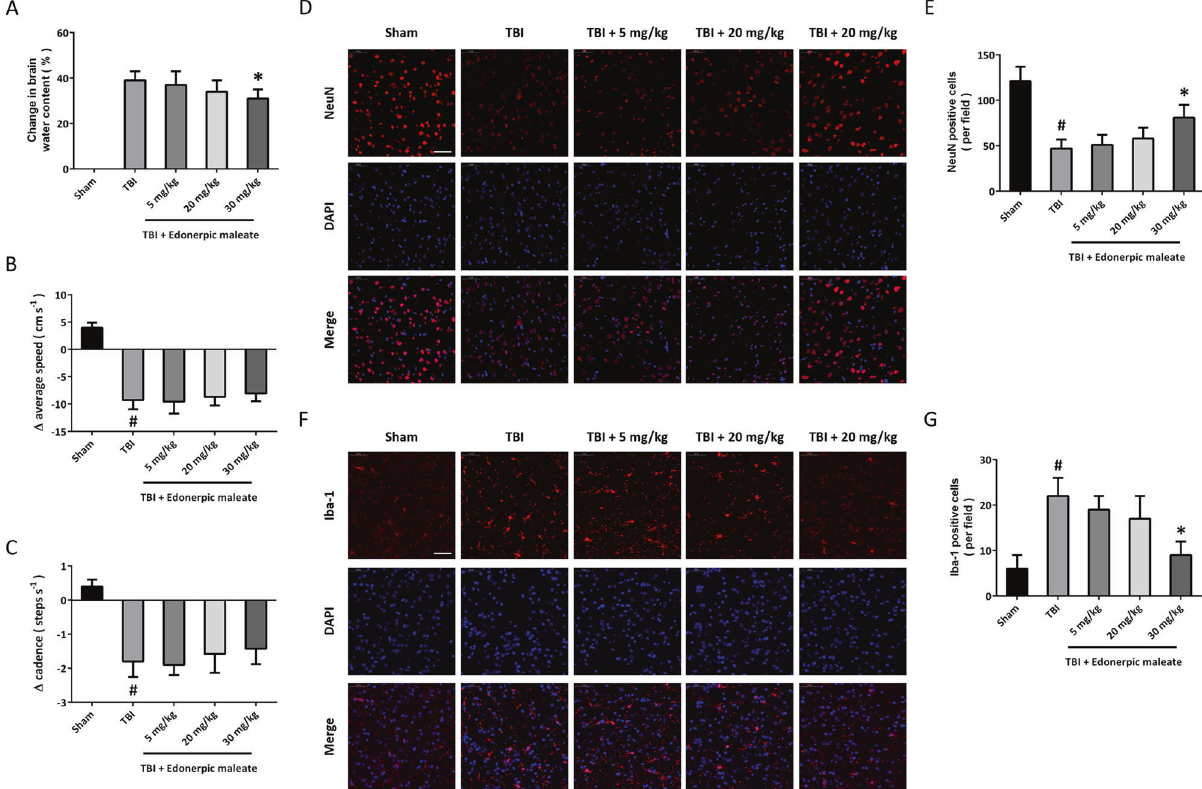
Fig. 5 Edonerpic maleate protects against brain damage after TBI. A Brain water content assay showed that 30 mg/kg edonerpic maleate reduced brain edema following TBI. B , C Edonerpic maleate at all doses used had no effect on locomotor speed ( B ) and cadence ( C ). D , E Immunostaining using NeuN antibody ( D ) and quanti fi cation ( E ) showed that 30 mg/kg edonerpic maleate decreased neuronal loss following TBI. F , G Immunostaining using Iba-1 antibody ( F ) and quanti fi cation ( G ) showed that 30 mg/kg edonerpic maleate attenuated microglial activation following TBI. Scale bar, 50 μ m. Error bars indicate SEM. # p < 0.05 vs. Sham. * p < 0.05 vs .